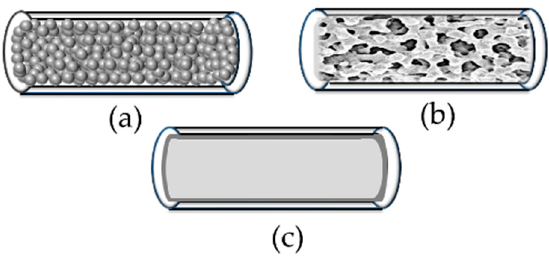
Figure 3. A schematic of ( a ) packed-bed; ( b ) monolithic; and ( c ) wall-coated microreactors.